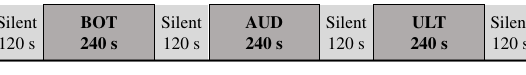
Figure 1. Presentation cycle of auditory stimulation (1). BOT, both audible and ultrasounds; AUD, only audible sound; ULT, only an ultrasound.